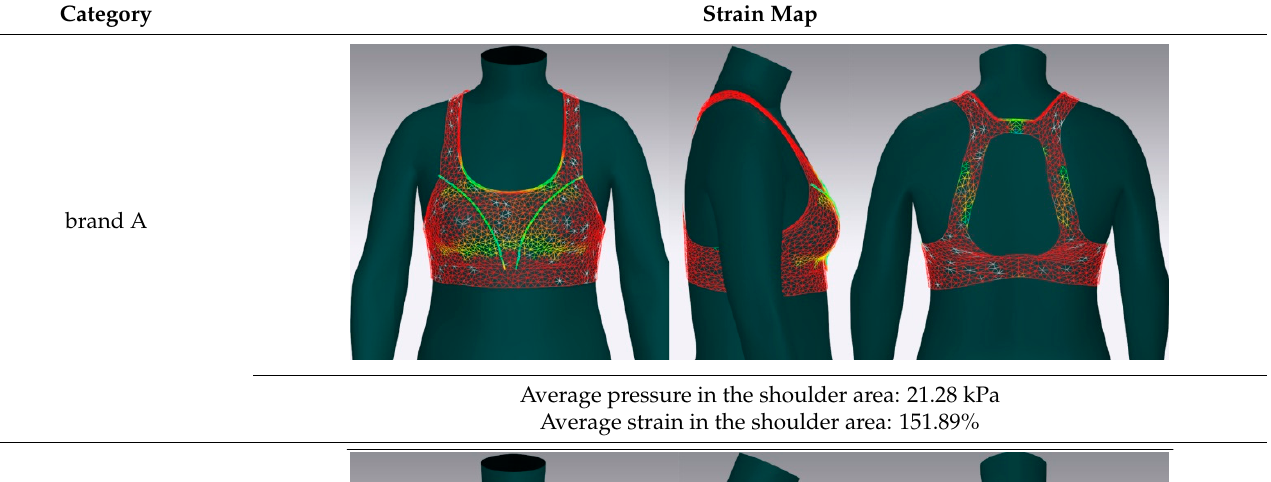
Table 5. Results of virtual fitting by Strain Map.